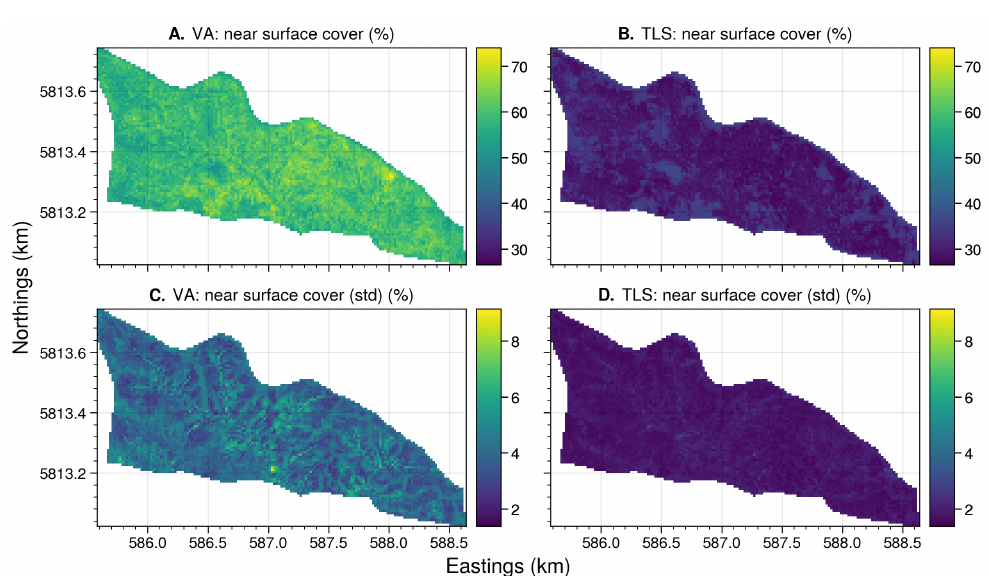
Figure A1. The mean and standard deviation of landscape level predictions for near-surface fuel cover using visual assessments ( A , C ) and TLS ( B , D ) at Lakes